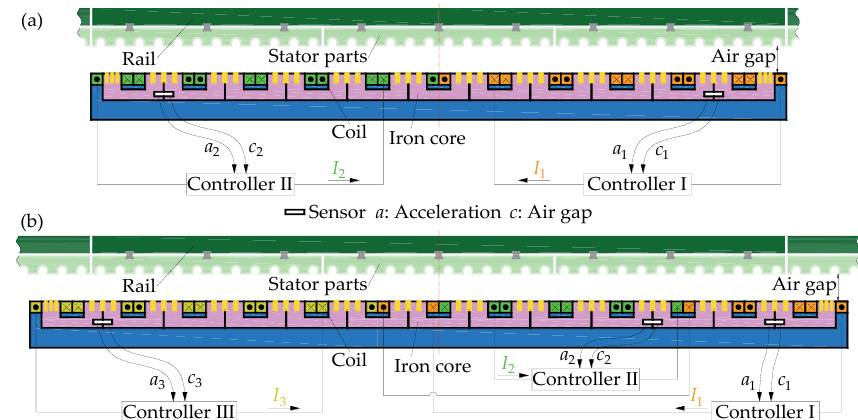
Figure 4. Physical architecture diagram of levitation control system: ( a ) SLM; ( b ) LLM.